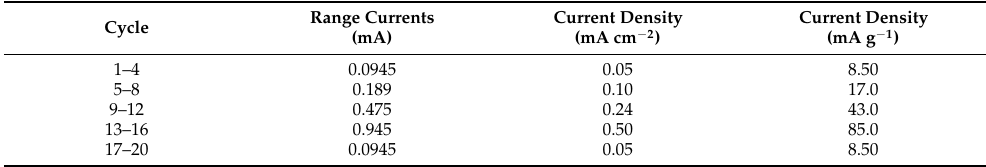
Table 1. Cycle range for different currents, current densities expressed in terms of area and